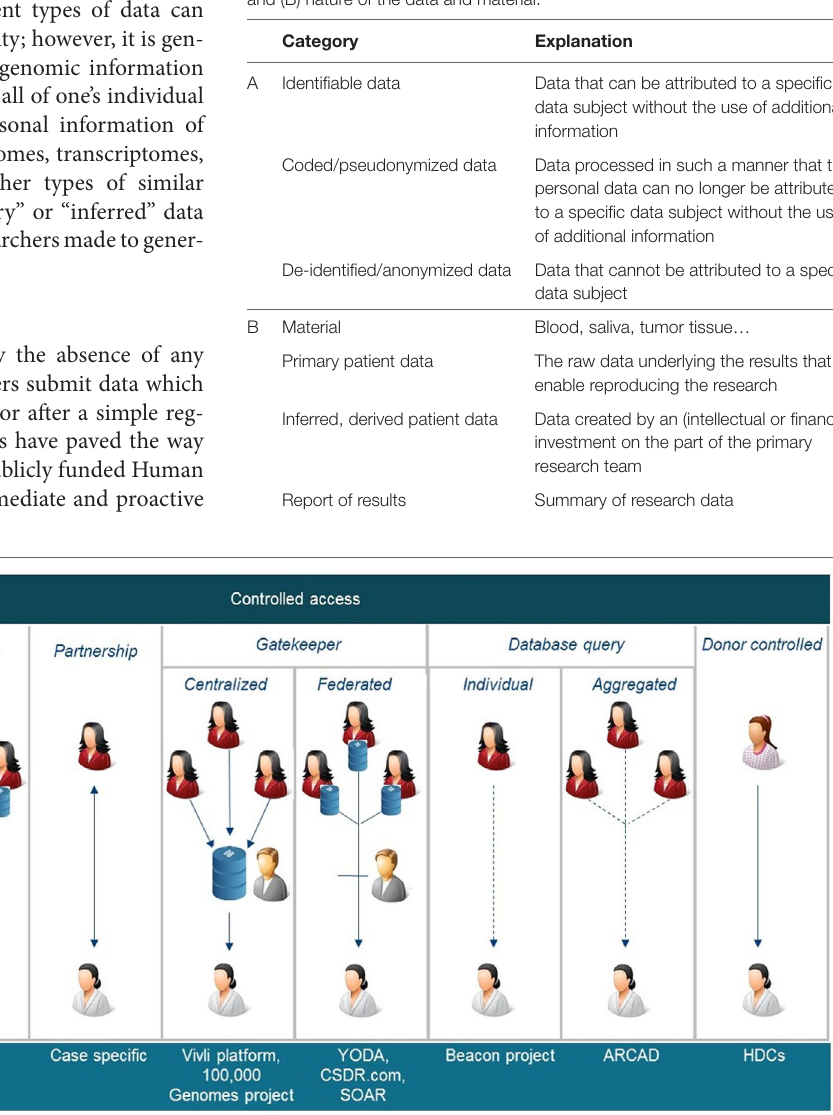
Table 2 | Categorization of data and material according to (A) level of identifiability or encryption to safeguard the protection of an individuals’ identity, and (B) nature of the data and material.